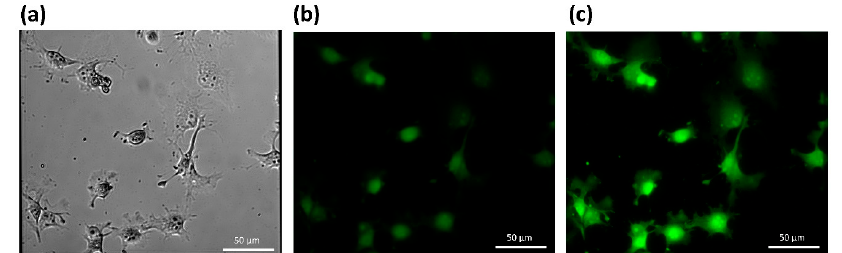
Figure 3. Excimer fluorescence of COS-7 cells before and after the EFP labeling induced by UV irradiation. Cells were fixed and reduced in advance. ( a ) Phase contrast microscopic image of COS-7 cells. ( b ) Fluorescence microscopy (FM) image of COS-7 cells before the EFP labeling. ( c ) FM image of COS-7 cells labeled with EFP using thiol-ene click reaction triggered by UV irradiation. Cells were brighter after the labeling; the nuclei were intensively labeled.